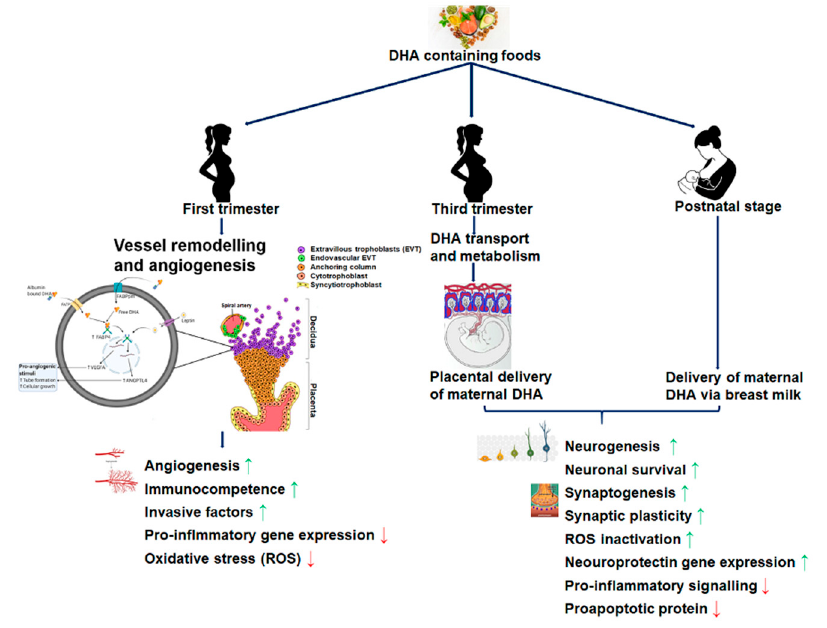
Figure 2. Maternal source and delivery of DHA at different stages of development affect fetoplacental and fetal brain development.